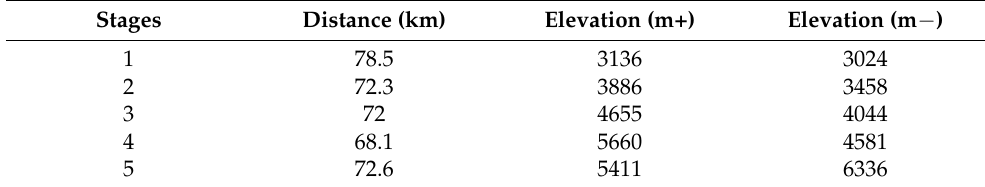
Table 2. Characteristics of the extreme ultra-trail